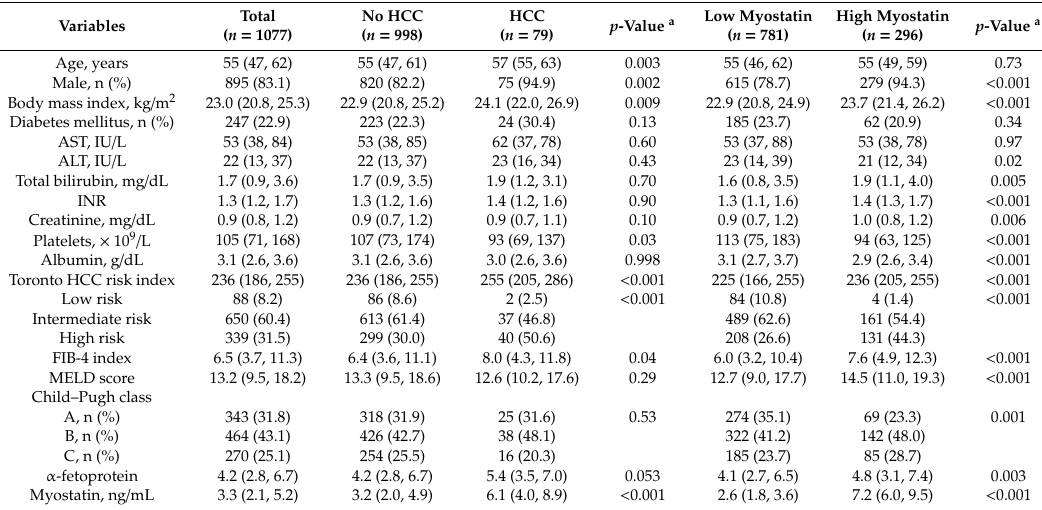
Table 1. Baseline